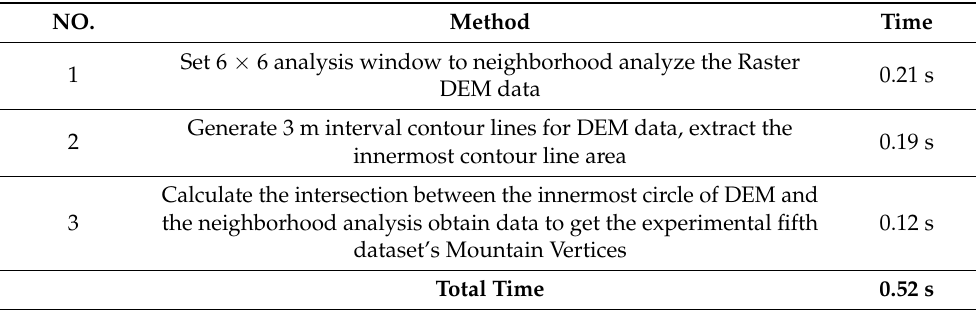
Table 18. The time spent in extracting mountain vertices for the fifth dataset using the Contour Line and Neighborhood Analysis Overlay